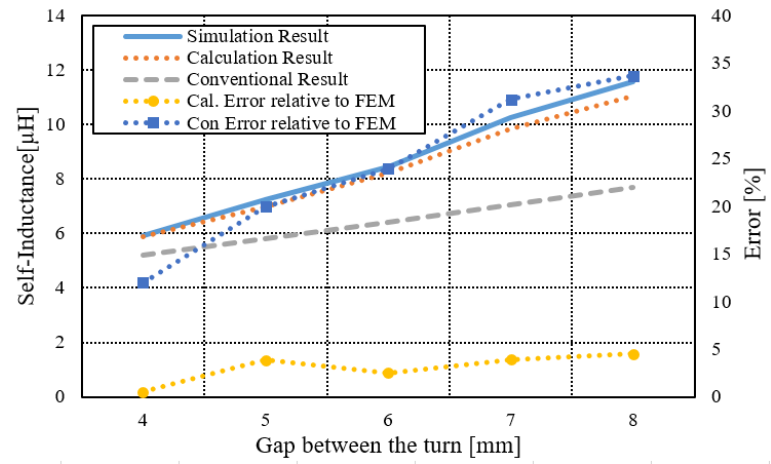
Figure 6. The influence of the change of the gap between a turn on the inductance of the spiral coil.